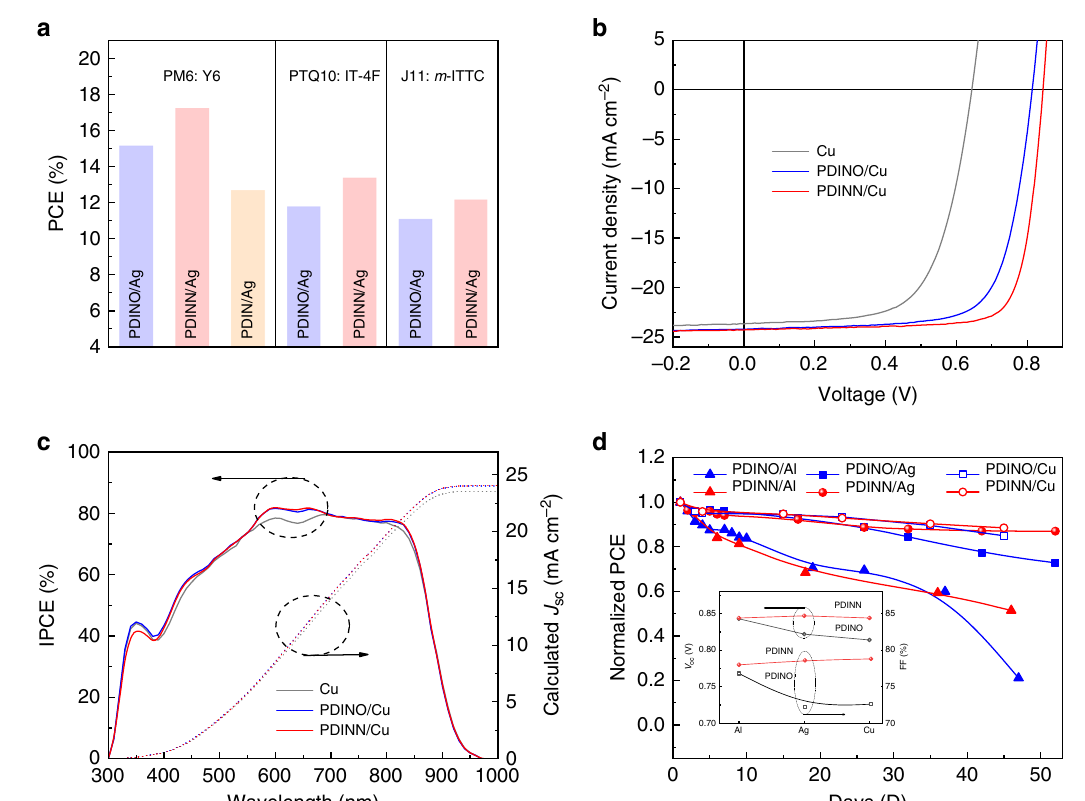
Fig. 4 Photovoltaic performance of the OSCs base on PM6:Y6. a The comparison of the PCEs of the OSCs with different CIMs and different photoactive layers under the illumination of AM 1.5 G,100 mW cm − 2 . b J – V curves of the best OSCs based on PM6: Y6 blend with copper as cathode under the illumination of AM 1.5 G,100 mWcm − 2 . c IPCE spectra and the integrated current density of the best devices with Cu as cathode. d Stability of the OSCs with different top cathode of PDINN/Ag or PDINN/Cu. The devices kept in nitrogen environment and in dark between the J – V